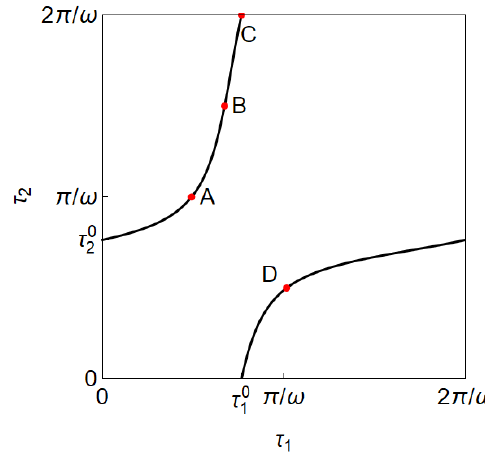
Figure 3. Stability switching curves for A = 0